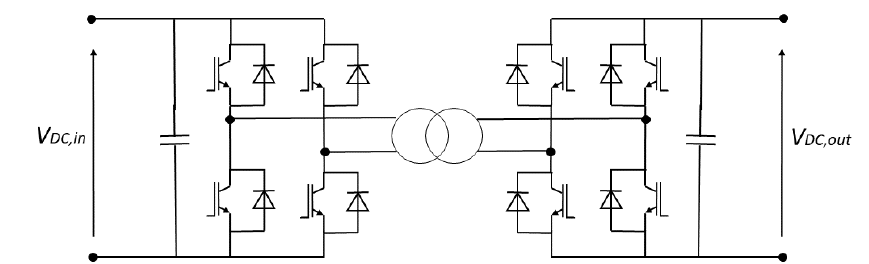
Figure 2. Single-phase dual active bridge converter topology.